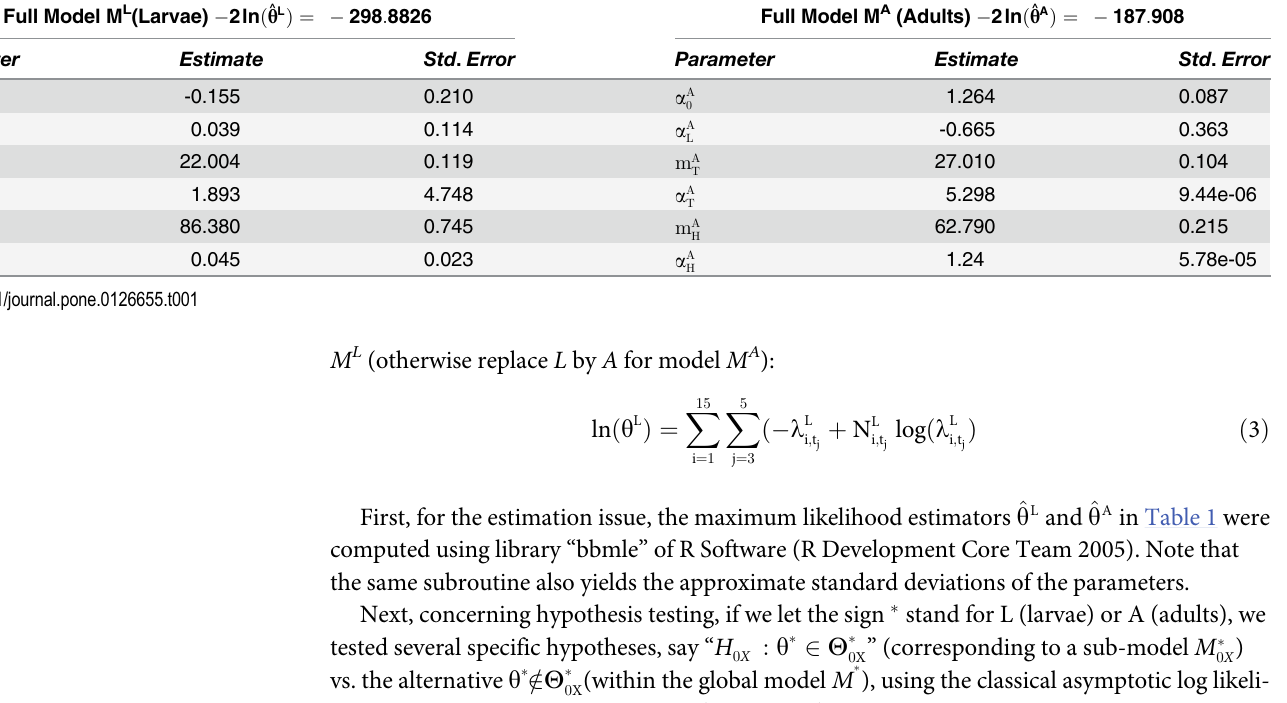
Table 1. Parameter estimates in full models for larva and adult presence in relation to climatic and other covariates. Full Model M L (Larvae) (cid:1) 2ln ð θ ^L Þ ¼ (cid:1) 298 :